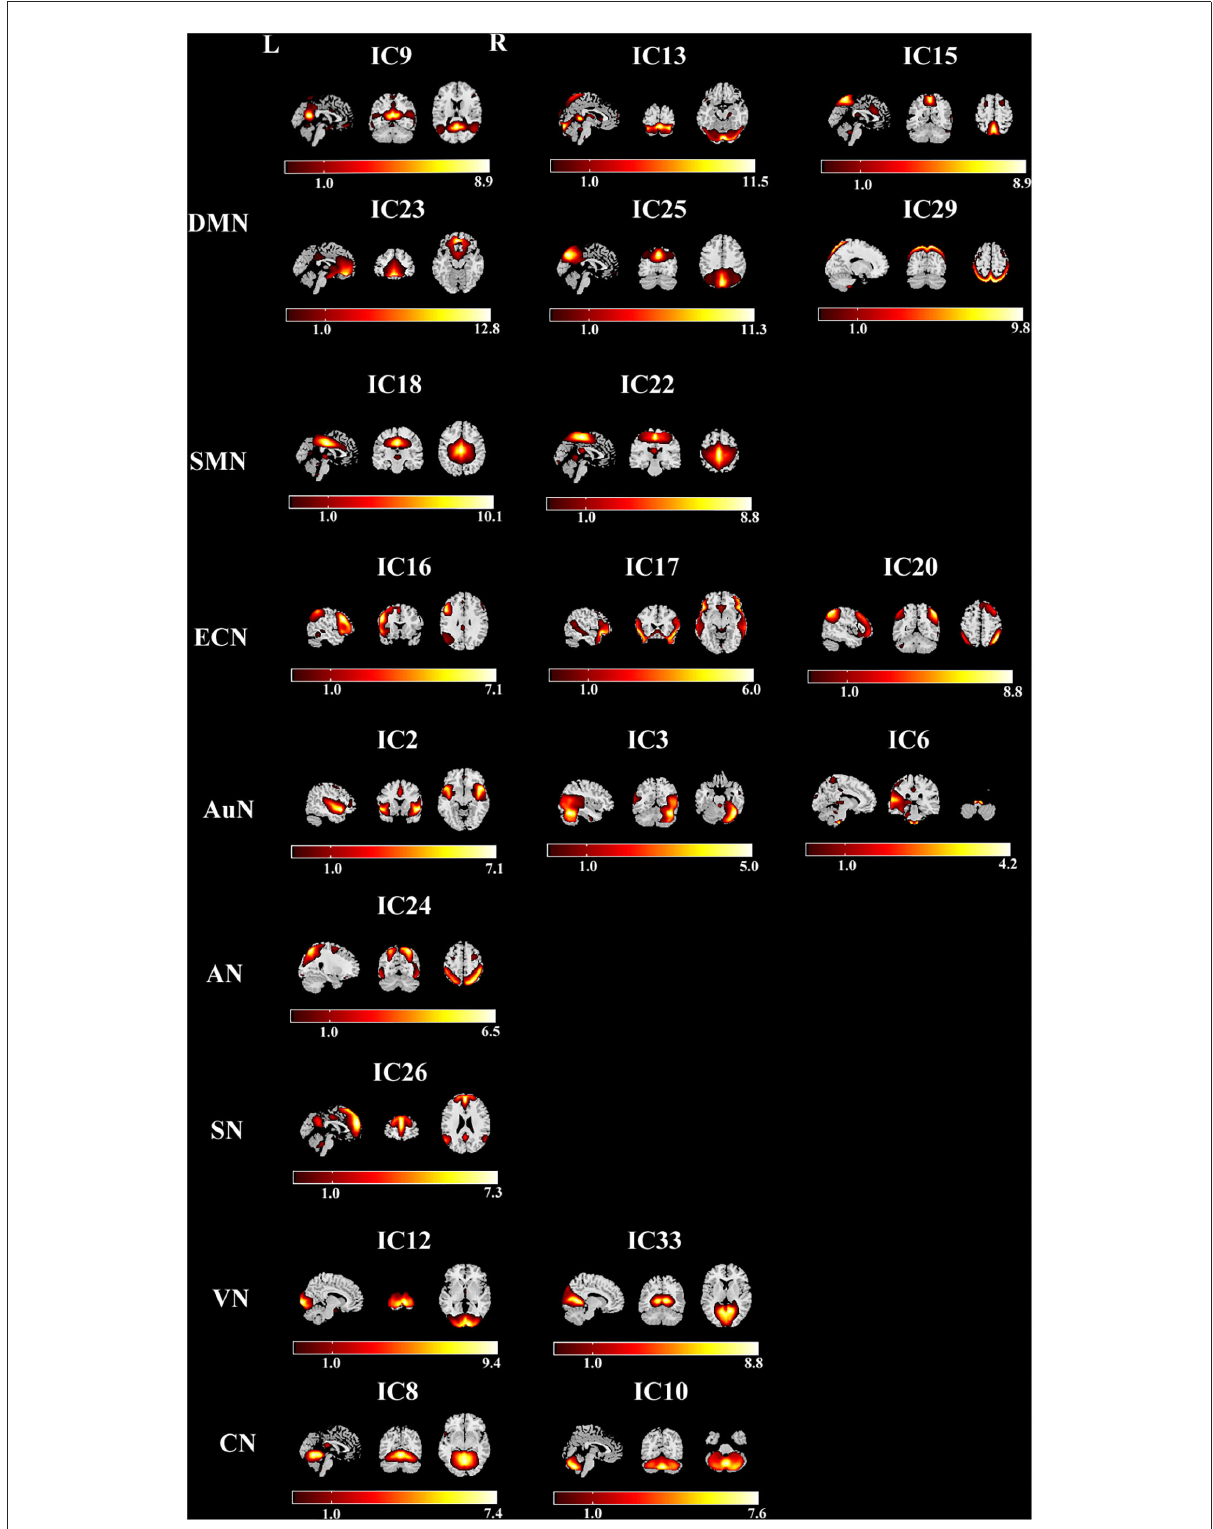
FIGURE1 The serial cross sections of the brain representing the eight networks with 20 components in the leukoaraiosis (LA) group. DMN, default mode network; SMN, sensorimotor network; ECN, executive control network; AuN, auditory network; AN, attention network; SN, salience network; VN, visual network; CN, cerebellum